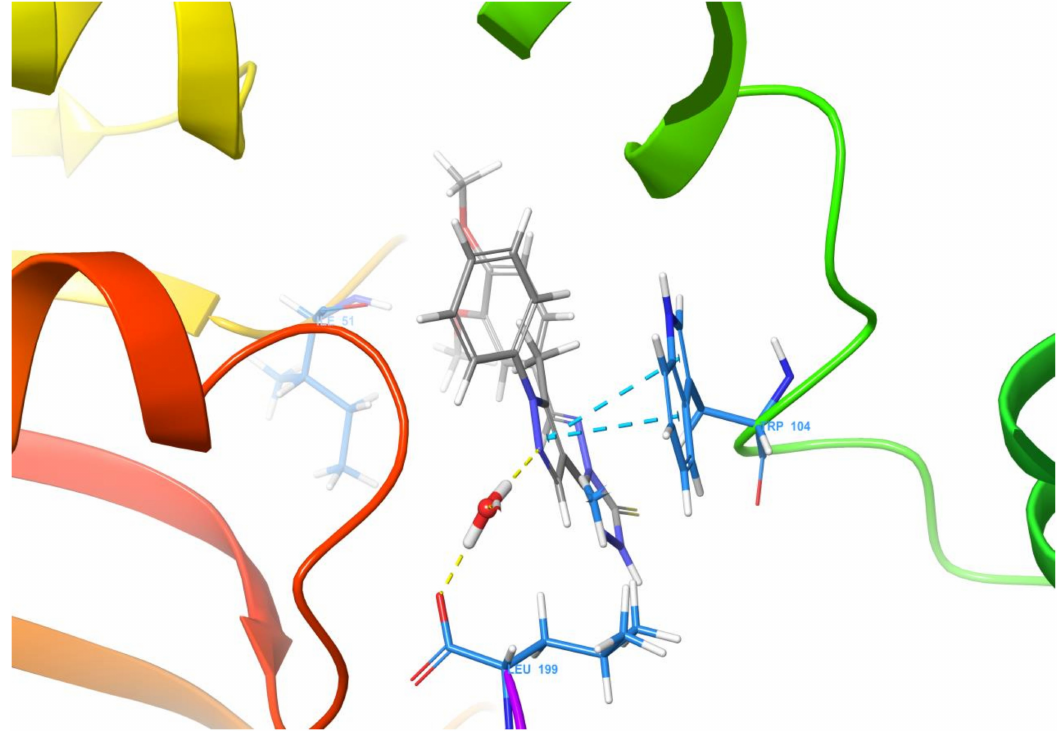
Figure 2. Ligand interaction diagram of the title compound 2 with human prostaglandin reductase